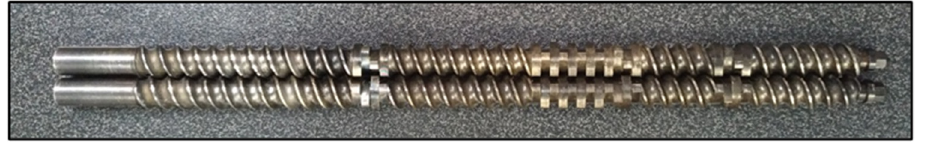
Figure 1. Screw profile used for the production of the composite filaments. The screws comprise three mixing zones separated by conveying elements. Polymer and fillers are fed at the conveying zone upstream. The polymer melts at the first mixing section. The remaining two mixing zones promote dispersive and distributive mixing.